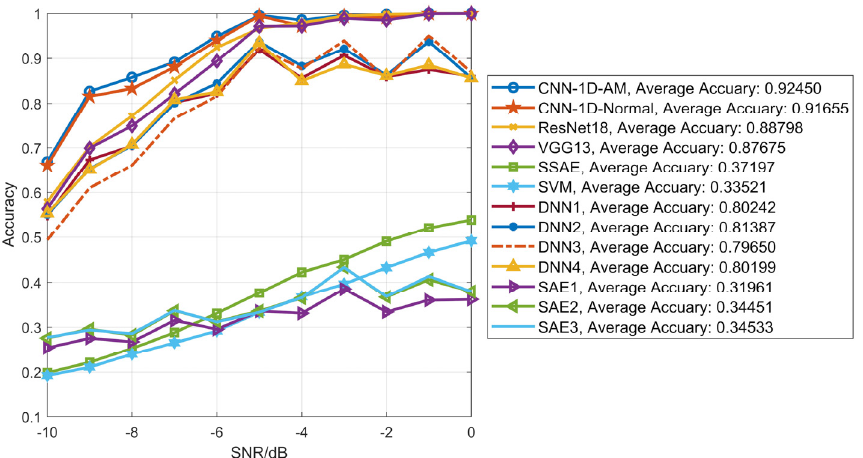
Figure 10. Recognition accuracy of different methods and models (CNN-1D-AM, CNN-1D-Normal, ResNet18, VGG13, SSAE, SVM, DNN1, DNN2, DNN3, DNN4, SAE1, SAE2, SAE3) with each value of SNR on the testing dataset. Table 6. The number of parameters and training time per epoch for convolutional neural network models.